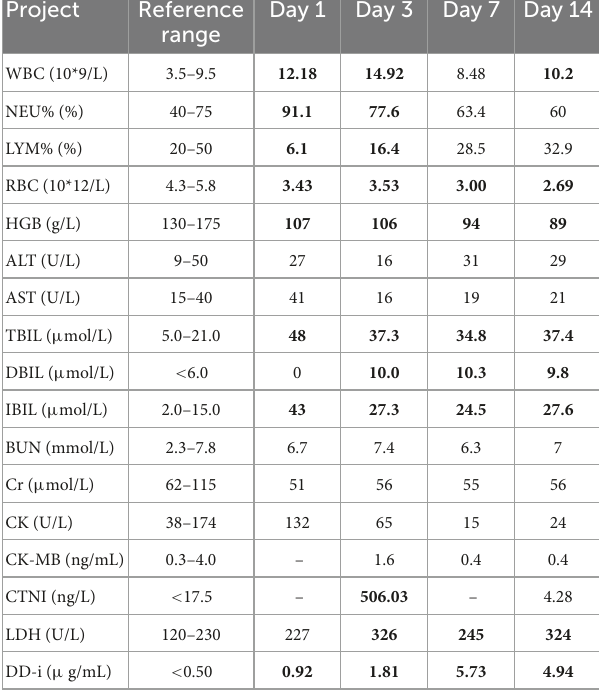
lacunar infarction in the right basal ganglia and a few ischemic degenerations in the white matter of both hemispheres ( Figure 3 ).